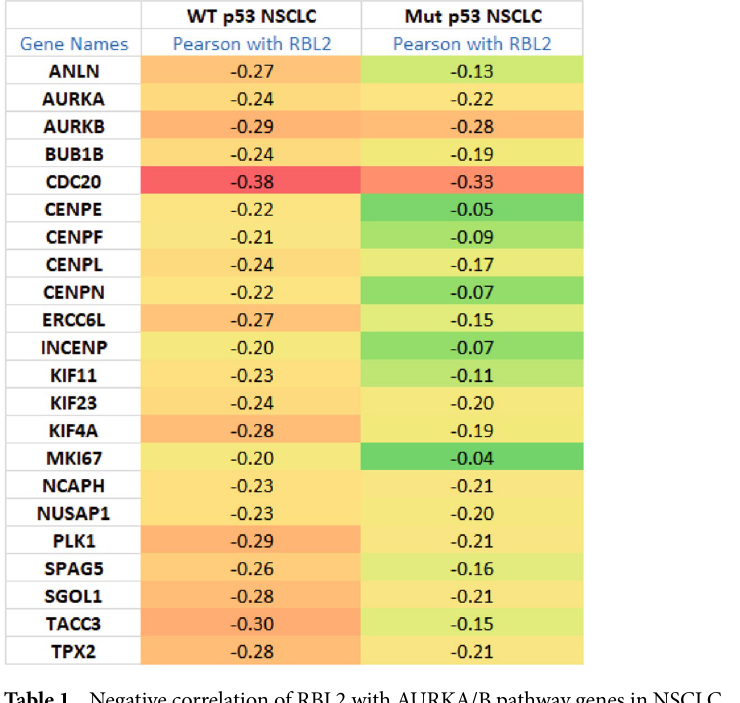
Table 1. Negative correlation of RBL2 with AURKA/B pathway genes in